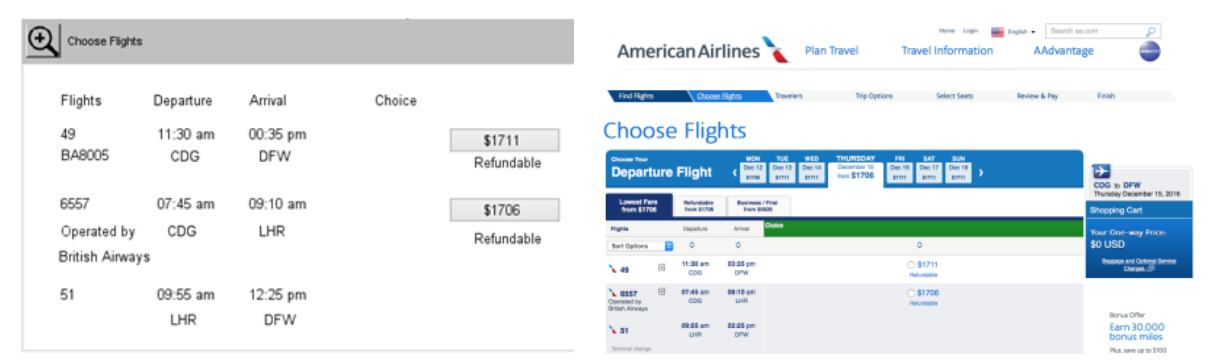
Figure 14. The “Find Flights” Prototype Figure 15. The “Find Flights” Final UI